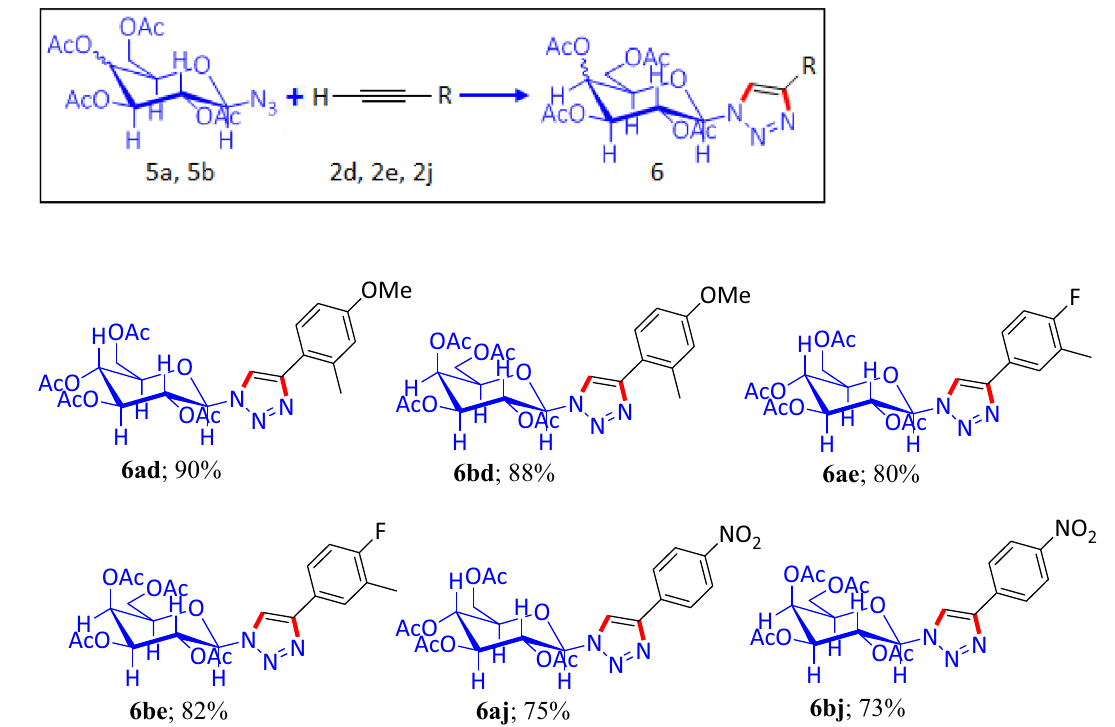
Table 4. Substrate scope for sugar azide and terminal alkyne and recovered catalyst (RC). Reaction condition: Aryl bromide (1 eqv), RC (10 mg), alkyne (1 eqv), MeOH (4 mL), Et 3 N (1 eqv), 25 °C, 3 h. Isolated